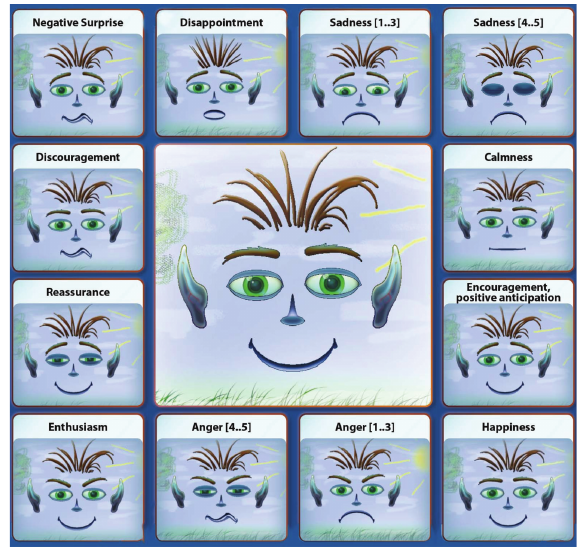
Figure 7: Amby’s facial expressions that reflect his emotions for the players